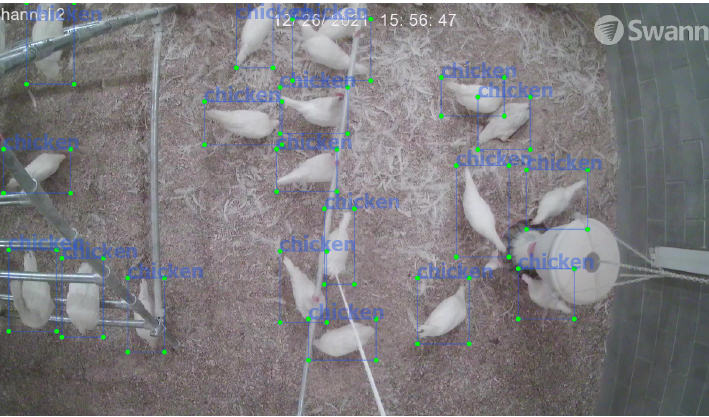
Figure 3. Examples of chicken image labeling.